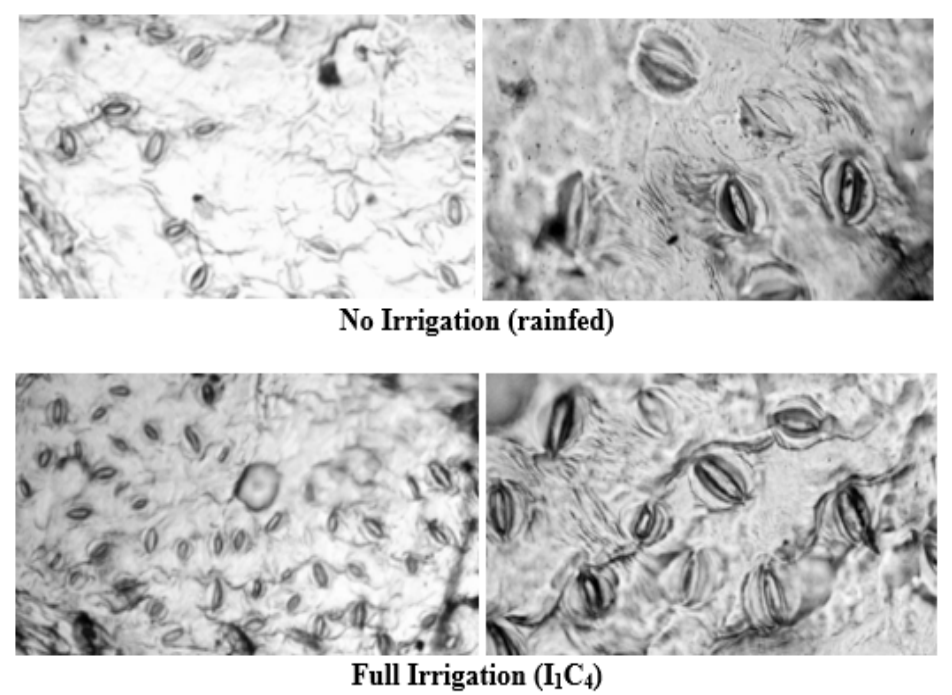
Figure 7. Stomatal density (No. of stomata/mm 2 ) under different levels of irrigation. Table 7. Effect of different irrigation levels at various crop phenological stages on stomatal size ( µ m) of apple (cv. Super Chief